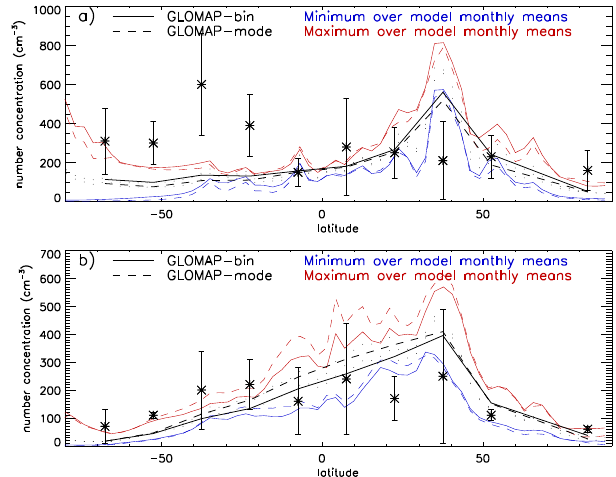
Fig. 13. Simulated marine surface zonal-mean size-resolved num- ber concentration in (a) Aitken mode and (b) accumulation mode, compared to those in the observed climatology (asterisks) for the marine boundary layer (Heintzenberg et al., 2000). The black lines show simulated annual mean values (averaged to the 15-degree grid) and the blue/red lines show minimum/maximum monthly- mean values. In (a) and (b) the solid lines are for GLOMAP-bin with the dashed lines for GLOMAP-mode (v6R). The error-bars around the asterisks show the observed standard-deviation in each latitude band. Values of b and R are shown in Table 5 from model annual-means (ocean grid boxes only) and by averaging up to the 15 degree grid to match the